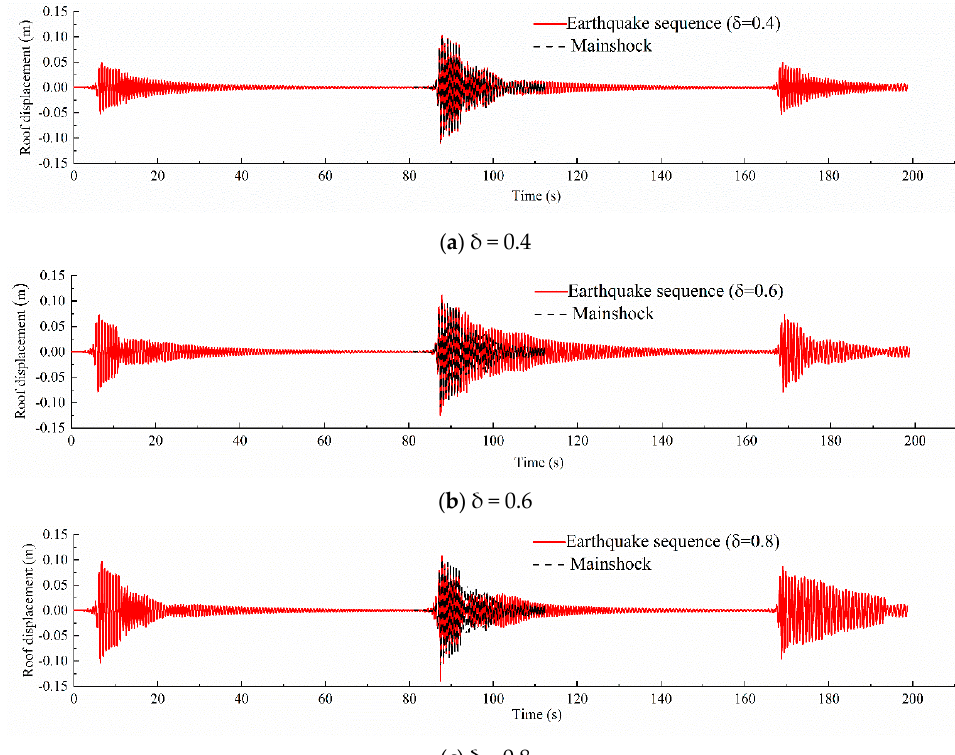
Figure 12. Comparison of the roof displacement of CFST-B under A-CAS input motion.